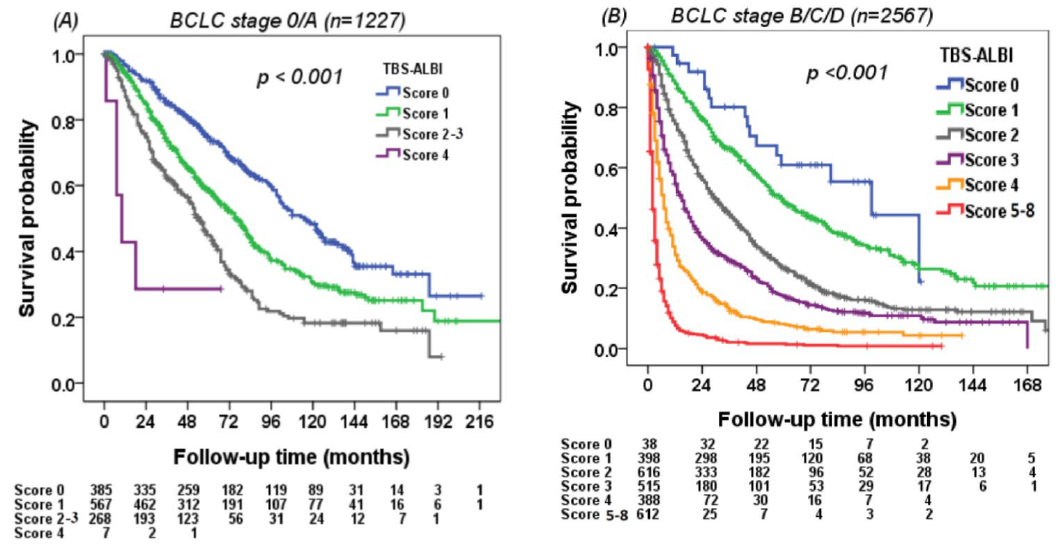
Figure 4. Survival distribution according to the TBS–ALBI system in ( A ) BCLC stage 0/A patients and ( B ) BCLC stage B–D patients. Patients with lower TBS–ALBI scores had better overall survival